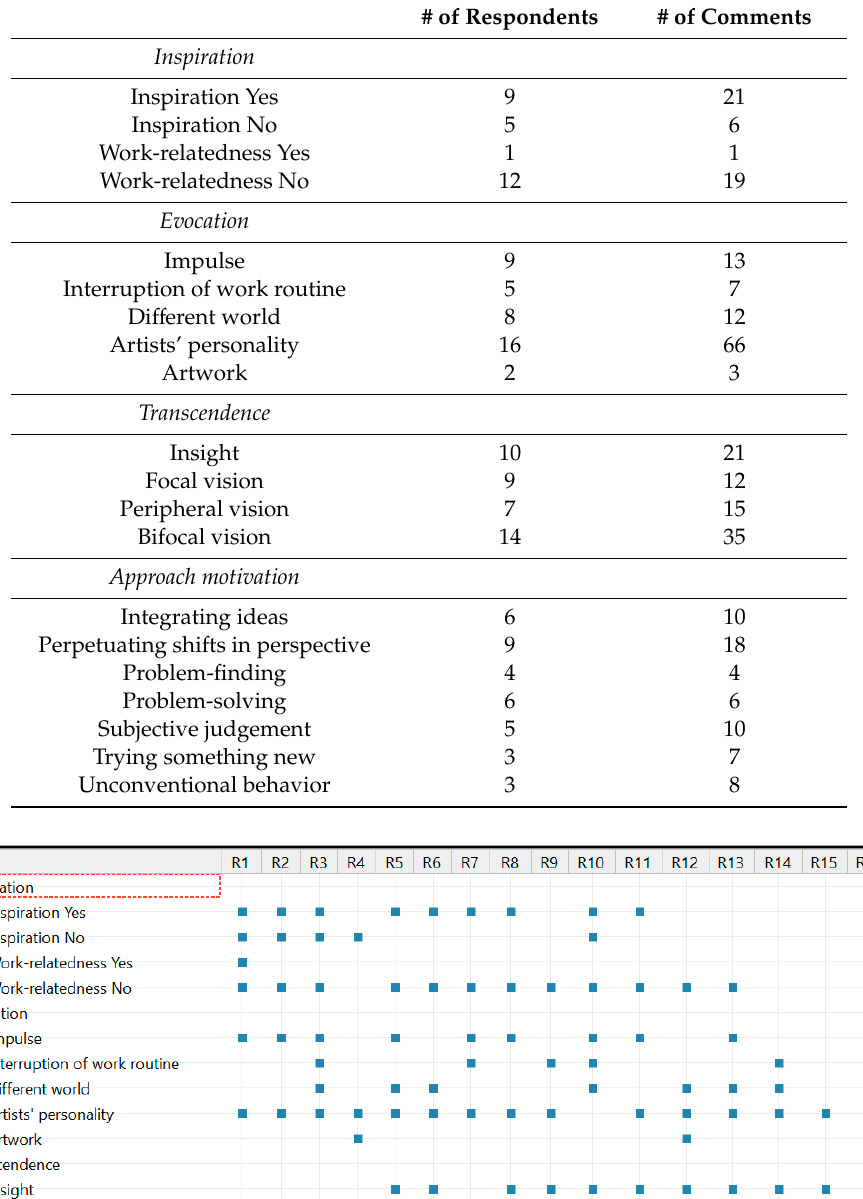
Table 2. Coding summary.